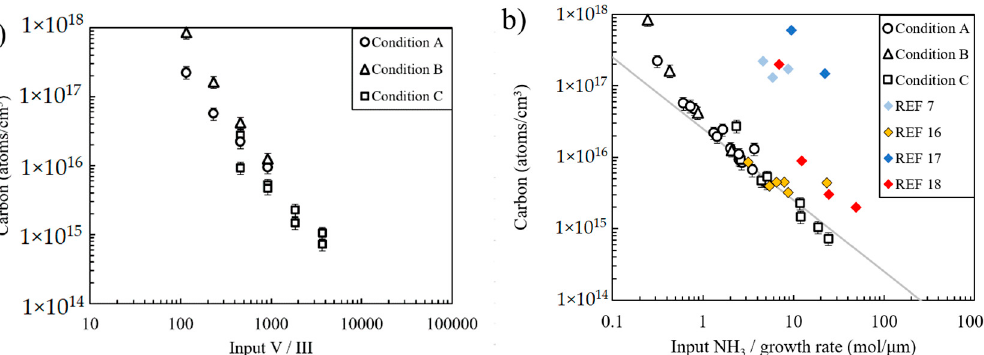
Figure 4. ( a ) Carbon incorporation versus input V / III ratio showing only data from this study. ( b ) Carbon incorporation versus input NH 3 / growth rate showing data from this study and data from the literature. The grey line is a guide to the eye aligned only to the data from this study, and it takes the form of a power law function with slope of − 1.